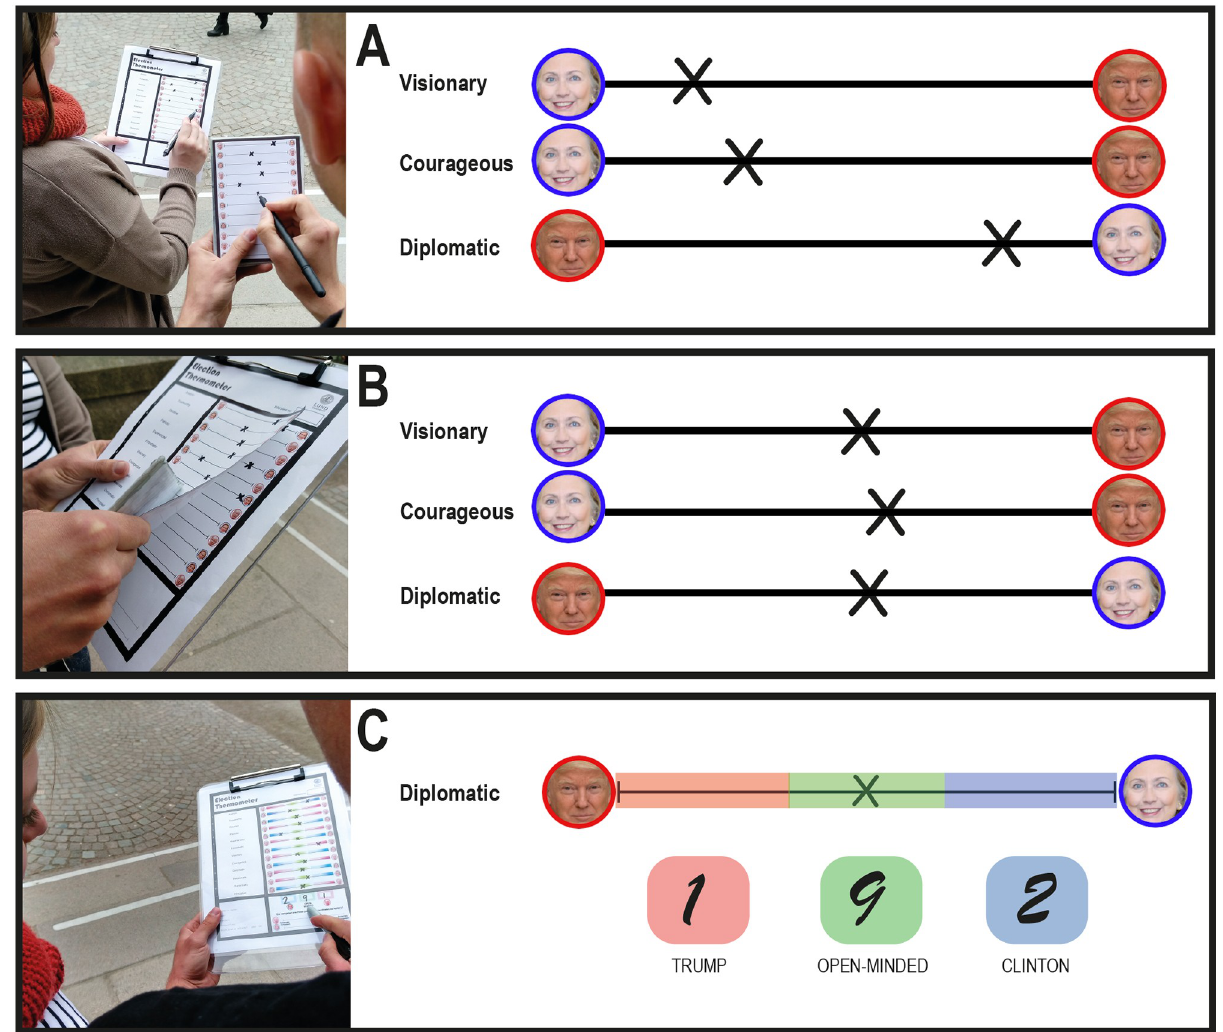
Fig 1. Paper survey. Participants filled out a paper survey rating Hillary Clinton and Donald Trump on 12 leadership traits, such as courageous and diplomatic . In the experimental group, while participants rated the candidates, we discreetly looked at their ratings and filled out an identical slip of paper with the majority of their polarized ratings shifted closer to the midpoint (A) . When the participants finished the survey, we briefly took it and covertly pasted our paper slip with the manipulated moderate responses on top of the participants’ original responses (B) . We then asked the participants to explain some of their (manipulated) ratings. Next, we overlaid a transparent sheet that categorized their ratings into: favoring Trump, favoring Clinton, or “open-minded” (i.e., neutral). Together with the participants, we tallied their ratings and asked them to explain their overall score. All participants in the experimental group now had a primarily open-minded score (C) . The participants in the control group did not receive any manipulations and instead explained their own original score. (Politician photographs from Wikimedia